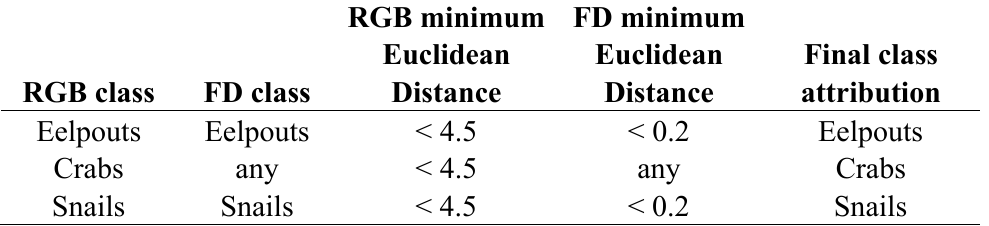
Table 1. Logical conditions for the class attribution with the KNN0